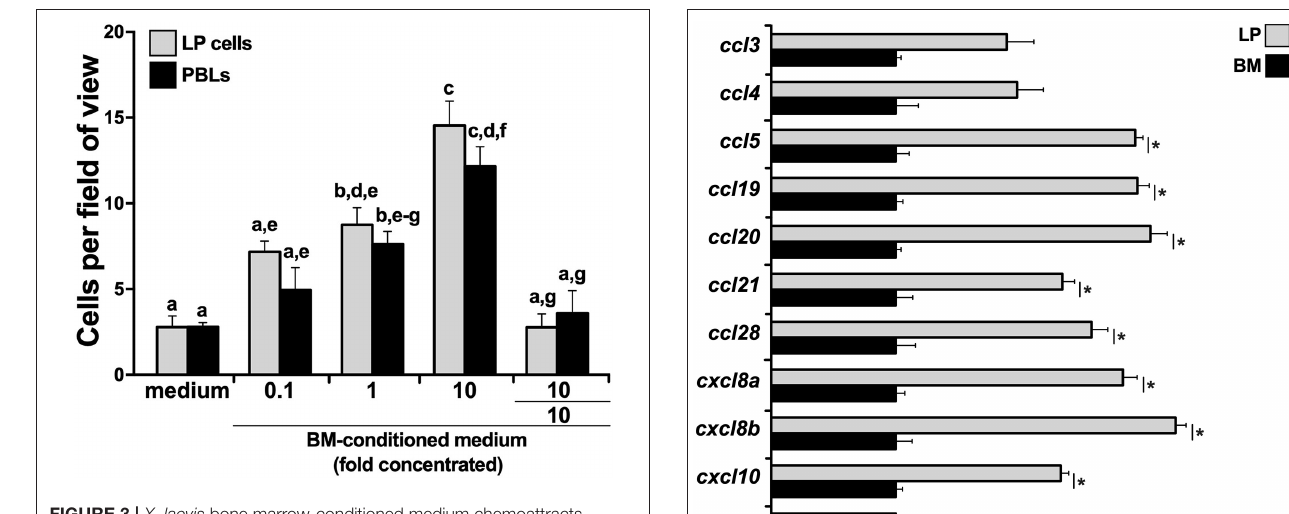
FIGURE 3 | X. laevis bone marrow-conditioned medium chemoattracts peripheral liver and blood leukocytes. Tenfold concentrated bone marrow-conditioned medium was serially diluted and examined for its ability to chemo-attract liver periphery (LP) cells and peripheral blood leukocytes (PBLs). Chemokinesis of LP cells and PBLs was measured by adding the tenfold concentrated BM-medium to both the upper and the lower chemotaxis chambers (denoted as 10/10). All chemotaxis/chemokinesis experiments were performed using cells from five individual animals ( N = 5), enumerating 10 random fields of view per chemotaxis filter per animal. Results are means ± SEM. Above-head letters denote statistical designations: experimental groups described by distinct letters are statistically different ( P < 0.05), while those marked by the same letters are not.